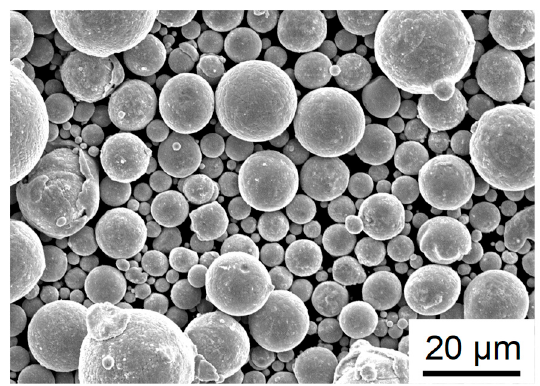
Figure 3. A secondary electron (SE) image of the CoCrFeMnNi alloy powder prepared by gas atomization.